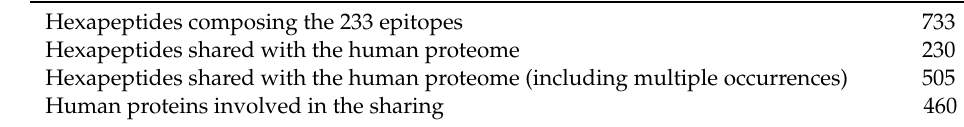
Table 1. Hexapeptide sharing between 233 epitopes present in SARS-CoV-2 and human proteins.